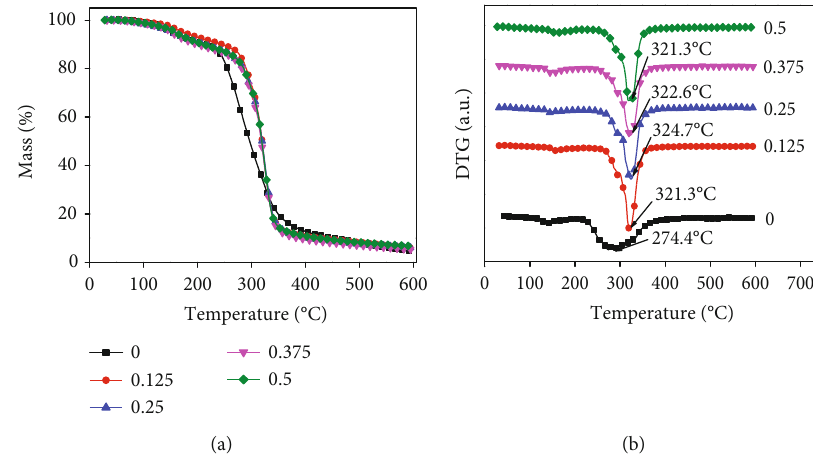
Figure 7: (a)TG curves of OWPF/TPS composites. (b) DTG curves of OWPF/TPS composites.